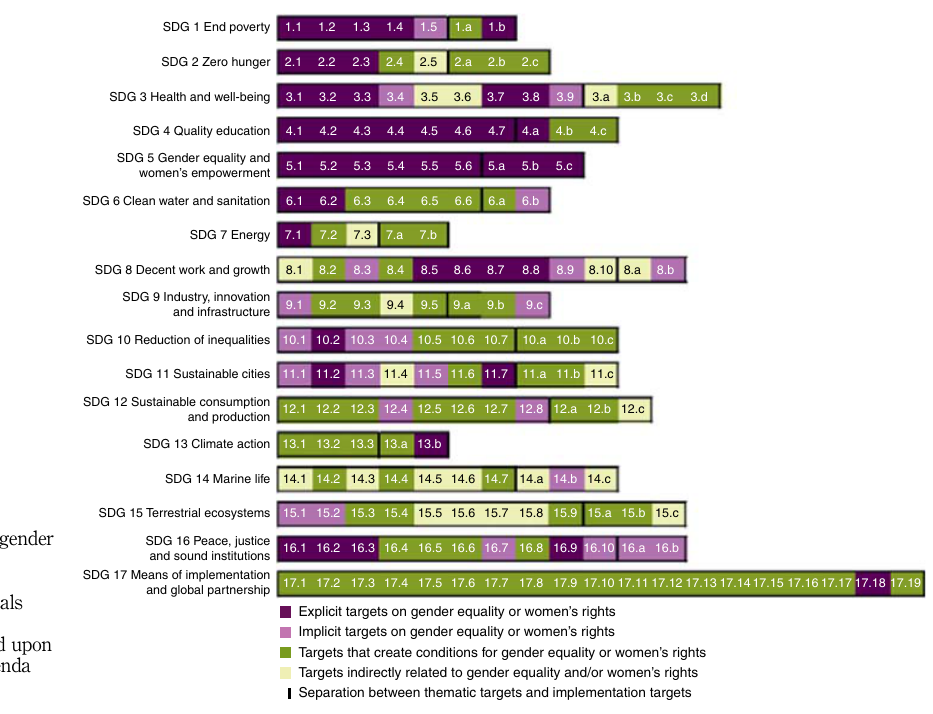
Source: ECLAC (2016, Figure 1.1, p. 30)